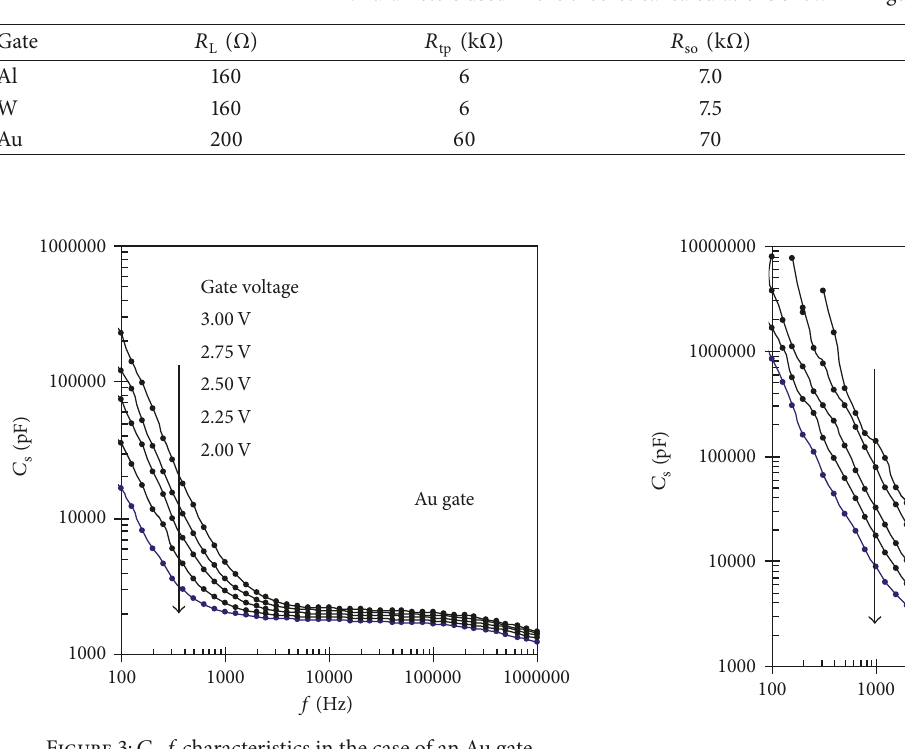
Figure 4: 𝐶 - f characteristics in the case of a W gate. s